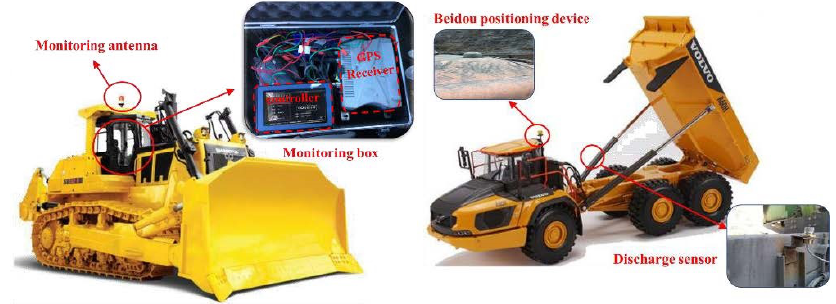
Figure 9. Equipment arrangement of monitoring terminal